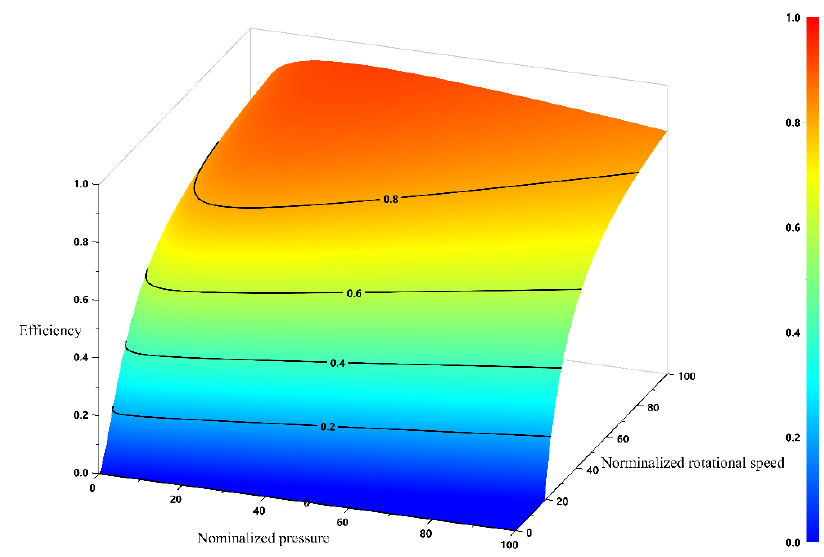
Figure 6. The pump/motor efficiency.